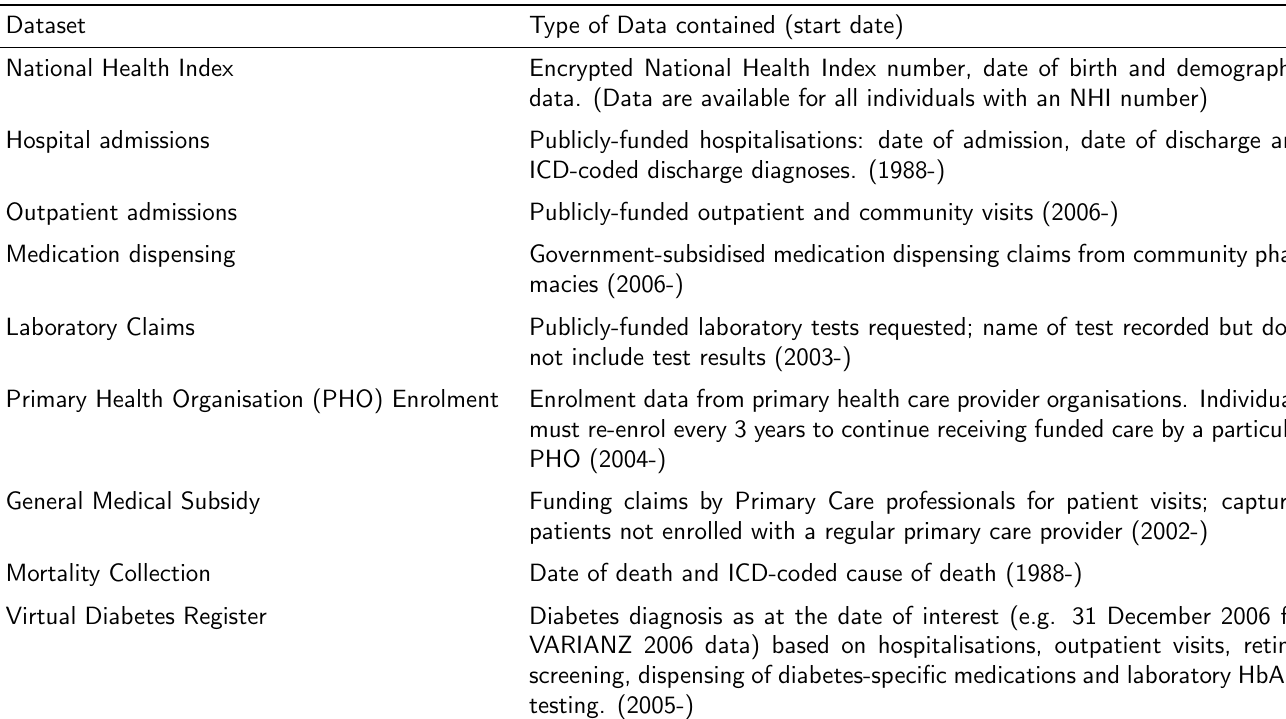
Table 1: Source datasets for Vascular Risk in Adult New Zealanders (VARIANZ)